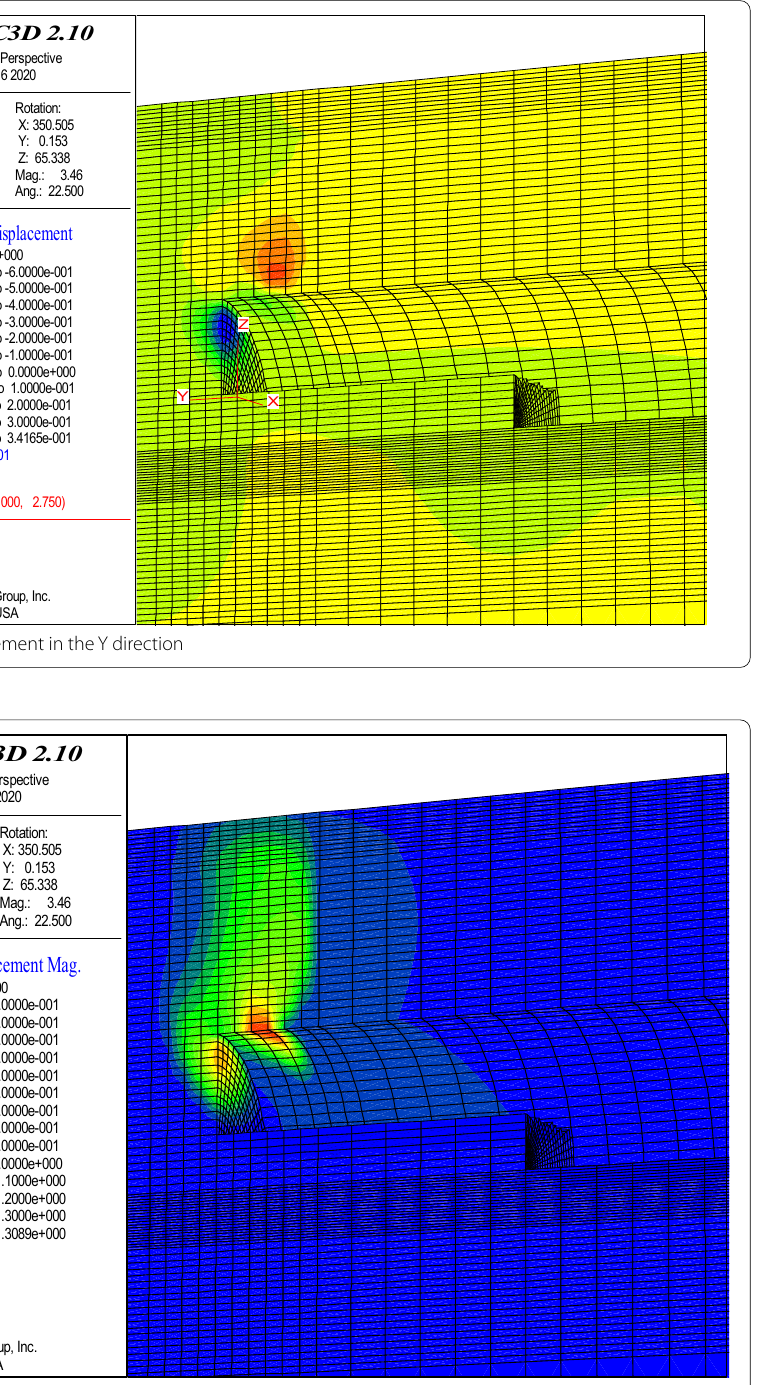
Fig. 19 Total displacement developed at the studied